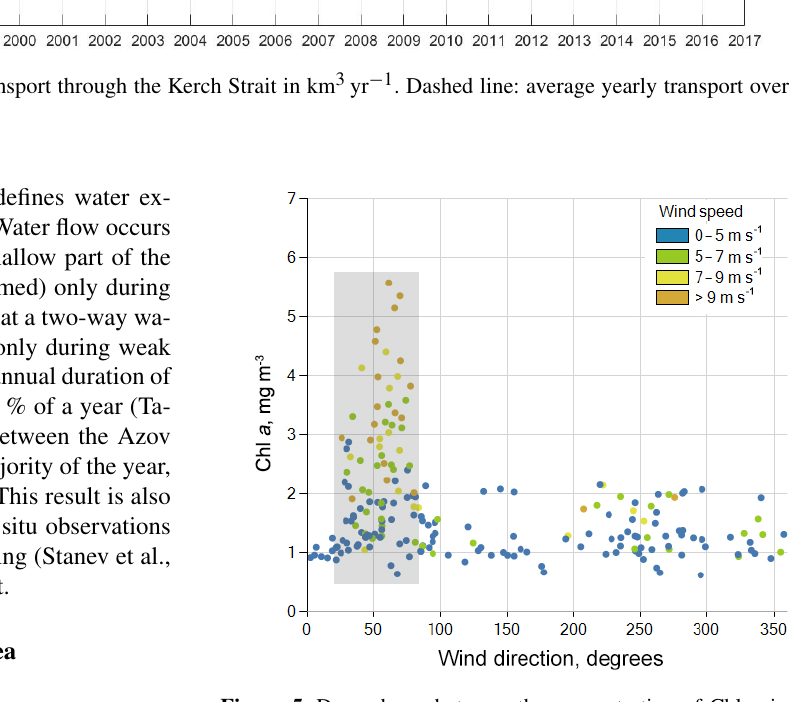
Figure 5. Dependence between the concentration of Chl a in the Kerch Strait and the adjacent area of the Black Sea retrieved from optical satellite imagery, on the one hand, and the direction of wind forcing averaged over 24h preceding satellite observations, on the other